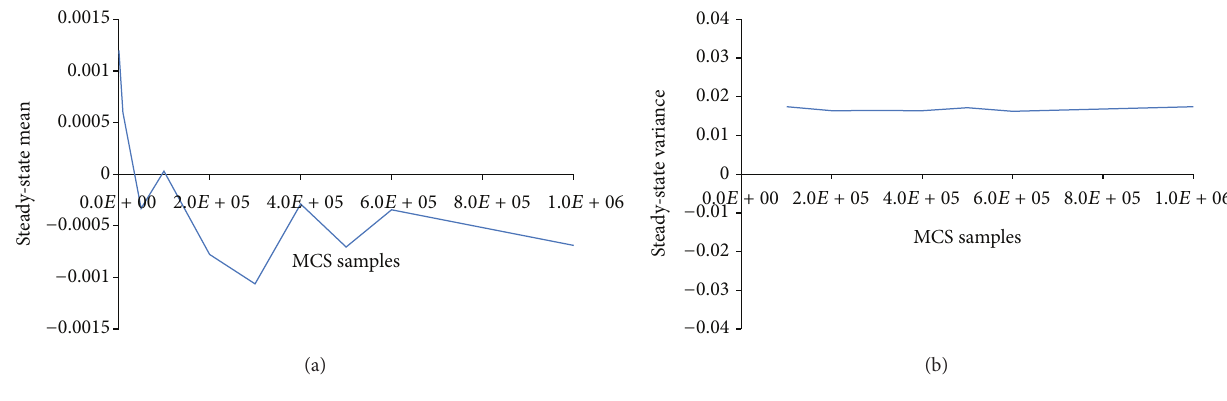
Figure 4: Steady-state mean (a) and steady-state variance (b) with the number of Monte-Carlo samples at x = 0.5 and 𝜆 = 0.5.